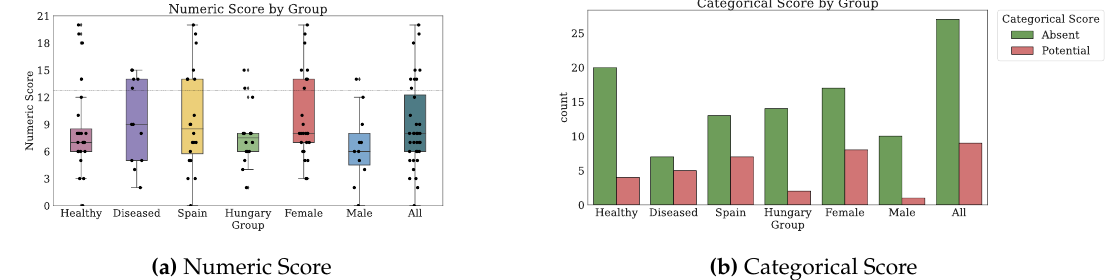
Figure A8. Scores for Memory (MFE). Dotted markings delimit levels of the categorical score Sleep Sleep (PSQI) 1309